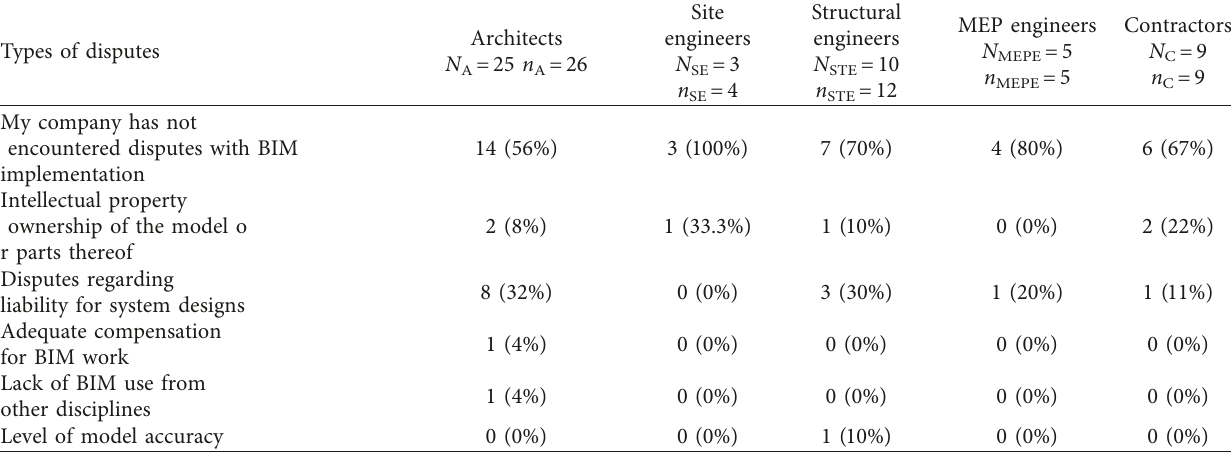
Table 12: Relationship between the role of the respondent and the kind of disputes their companies have encountered when implementing BIM in educational facility projects ∗